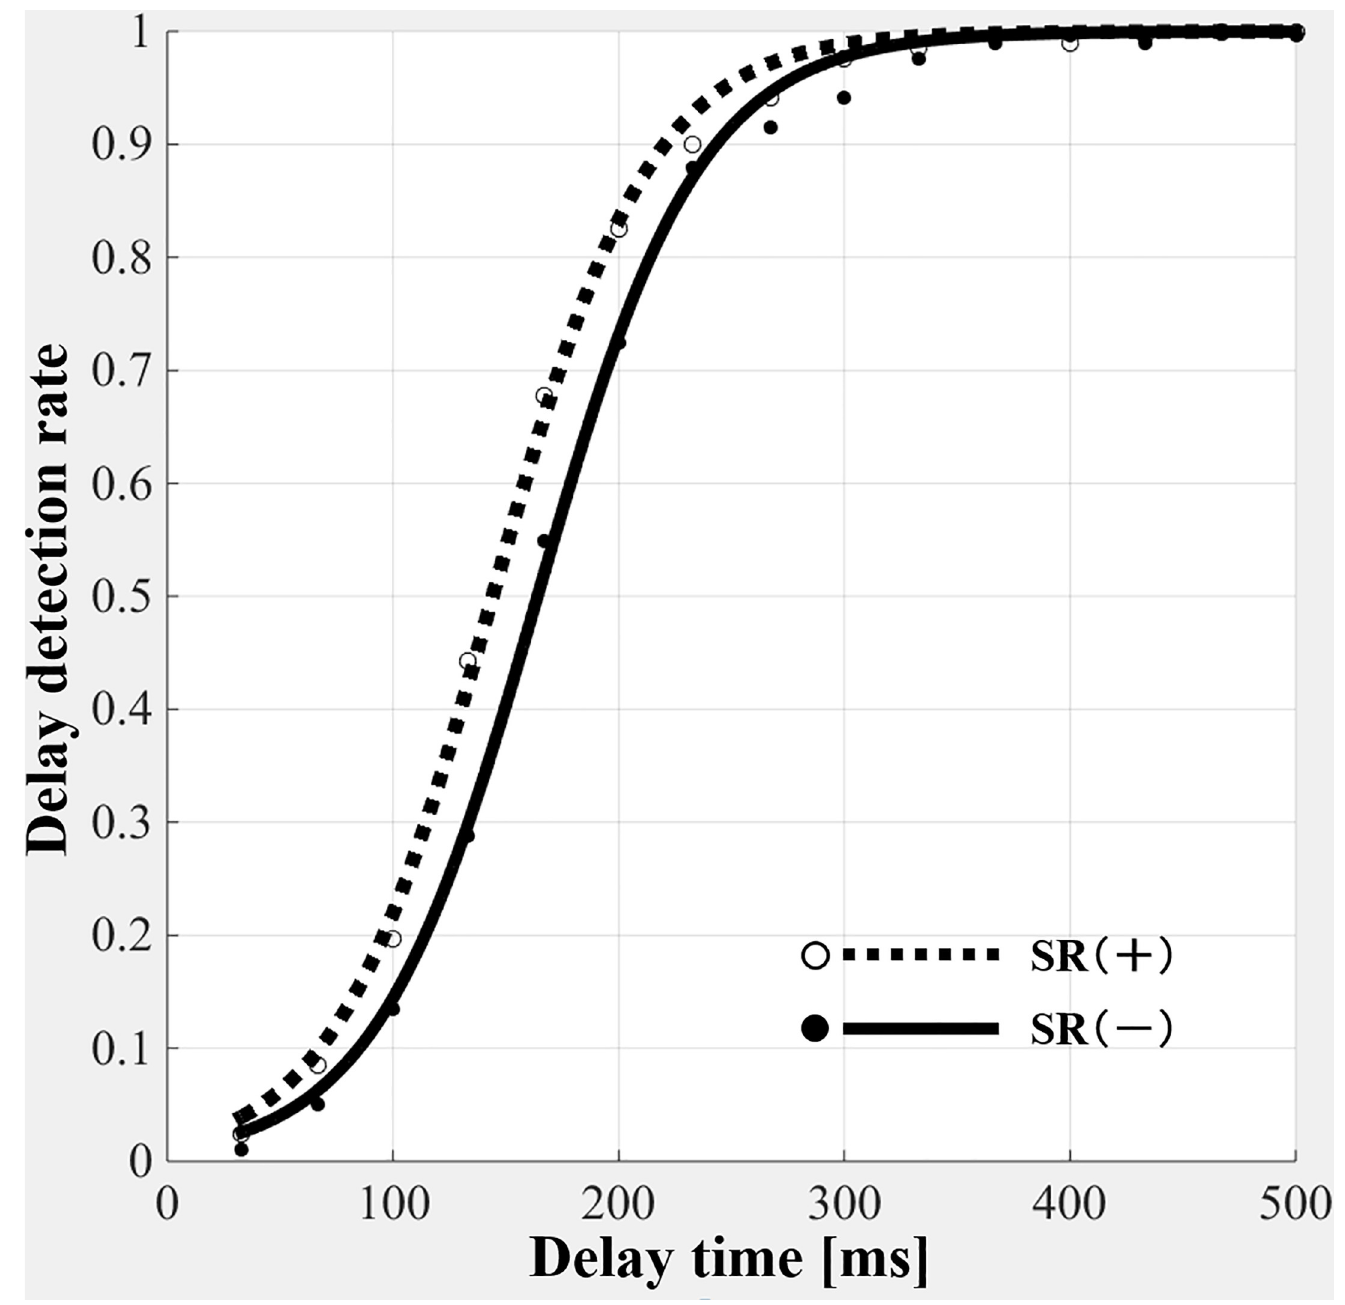
Fig 4. Delay detection probability curves of the delayed visual feedback detection tasks in the stochastic resonance on- and off-conditions. SR (+), stochastic resonance on-condition. SR (-), stochastic resonance off-condition. In delay detection probability curves, shifting the curve to the left and increasing the slope of the curve represent a high performance of visuomotor temporal integration. The probability curve of SR (+) shifted to the left, although its steepness was equivalent compared to the probability curve of SR (-).